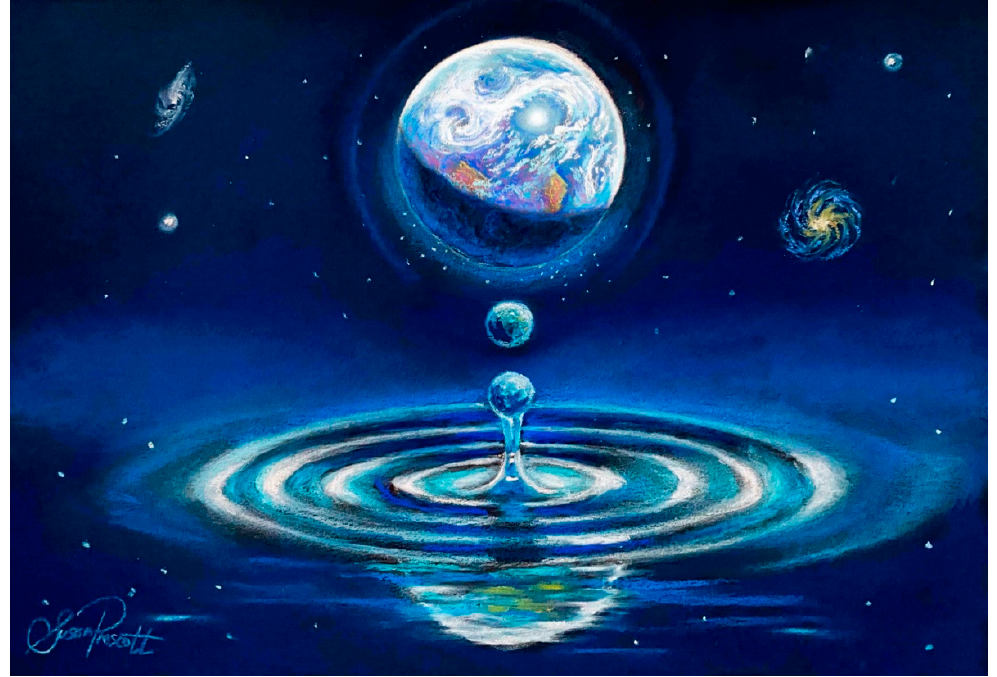
Figure 9. Project Earthrise. Creating ripples of change to bring the future into new focus through the power of imagination—it is time to imagine what kind of world we want to live in. Artwork by